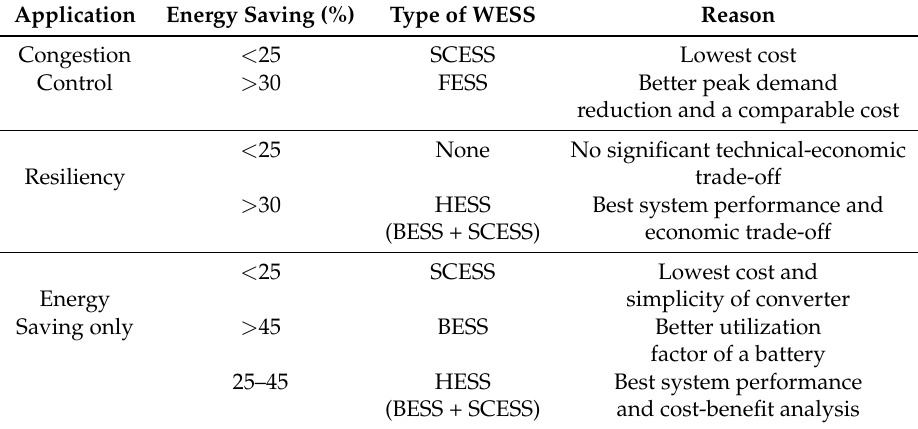
Table 2. Application specific choice of